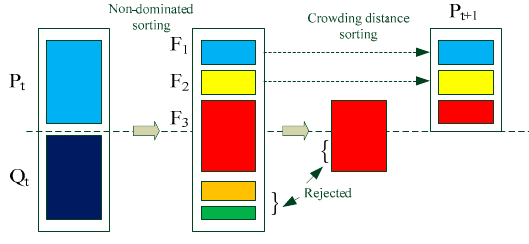
Figure 5. The NSGA II procedure [28].